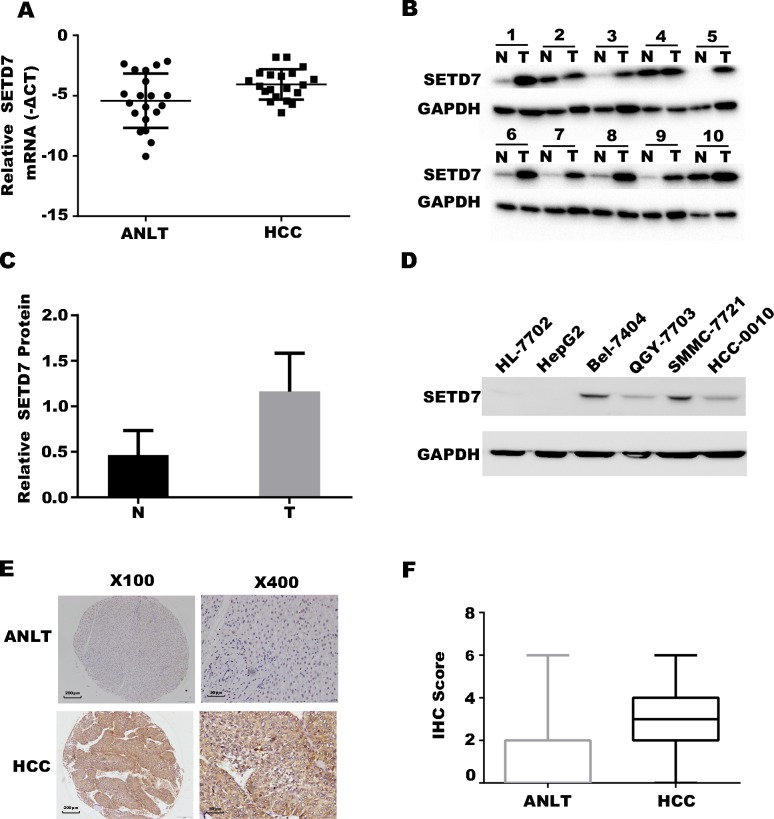
Expression of SETD7 in HCC tumor tissues, paired ANLTs and cell lines.(A) qRT-PCR analysis was performed to analyze SETD7 expression in 20 pairs of HCC tumor tissues and ANLTs, the data shown are the mean of –ΔCT, and the expression of SETD7 in HCC is significantly higher than that in ANLTs (P<0.05); (B) Western blot assay was performed to detect SETD7 expression in 20 pairs of HCC tumor tissues and ANLTs; (C) Gray value of Western blot result (P<0.05); (D) Western blot assay was performed to analyze SETD7 expression in normal hepatocyte cell line (HL-7702) and liver cancer cell lines (HepG2, SMMC-7721, QGY-7703, HCC-0010, and Bel-7404); (E). Typical IHC staining of SETD7 in HCC tumor tissues and ANLTs (with figures on the left magnified 100× and figures on the right magnified 400×); (F) Box plots indicate the IHC scores of SETD7 in HCC tumor tissues and ANLTs [mean, 3.204 (SD, 0.092) vs 1.427 (SD, 0.083), P<0.01].